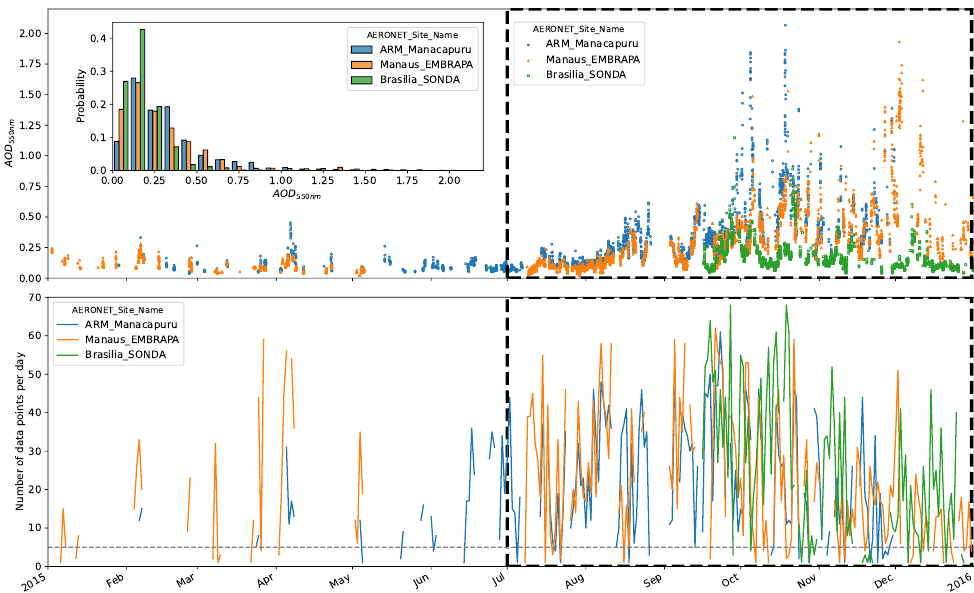
Figure 1. Time series for 2015 ( top ) indicating the selected period of study (thick black dashed line rectangle). The probability distribution of aerosol optical depth (AOD) at 550 nm for the period of study is plotted in the inset. Only level 2.0 AOD data from AERONET is presented. The bottom panel displays the daily number of data records. The dotted line represents the threshold (five records) adopted for minimum records number to guarantee the representativeness of daily aerosol